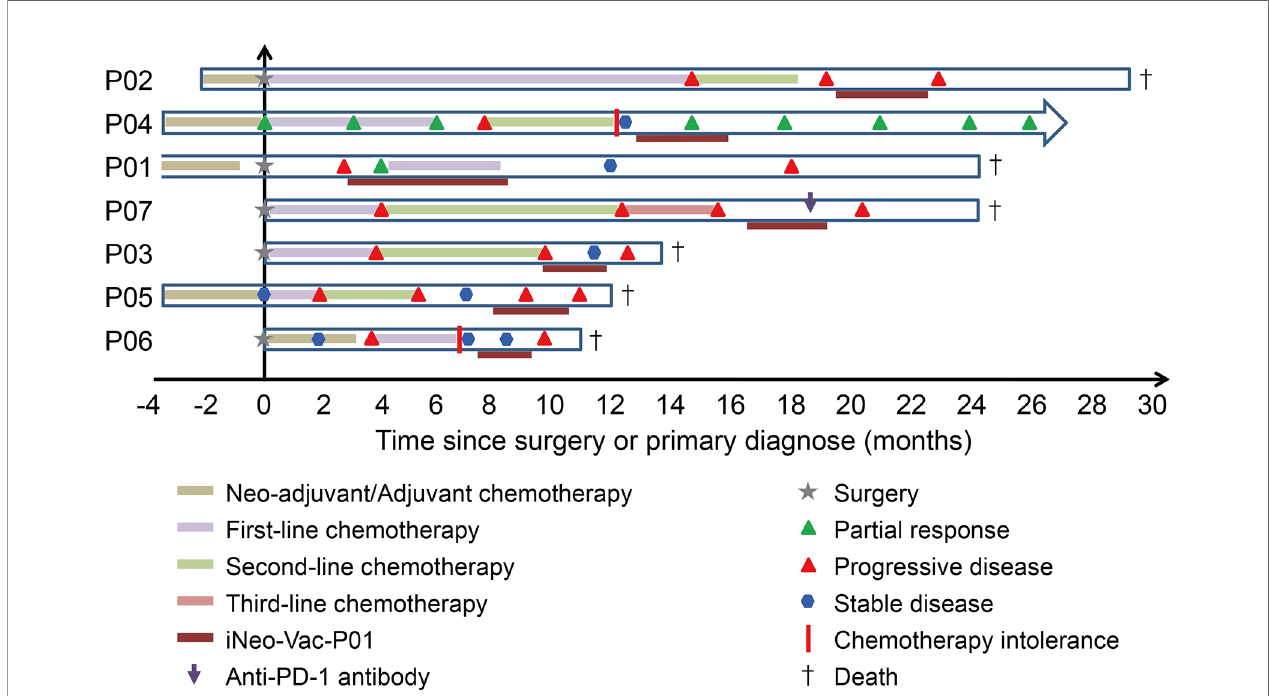
FIGURE 1 | Clinical treatment process for each patient from surgery or primary visit until the end of